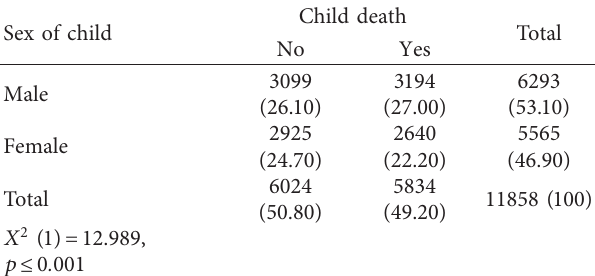
Table 15: Sex of child on child mortality.